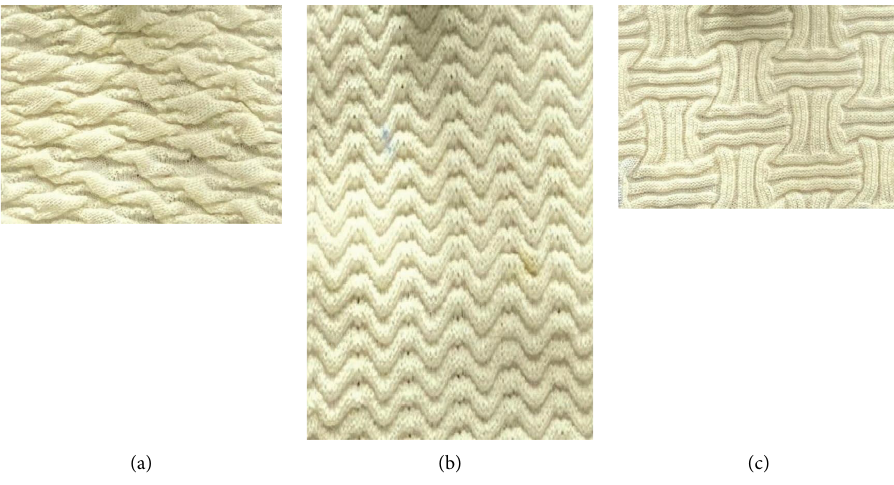
Figure 9: Developed structures: (a) star, (b) lines, and (c)